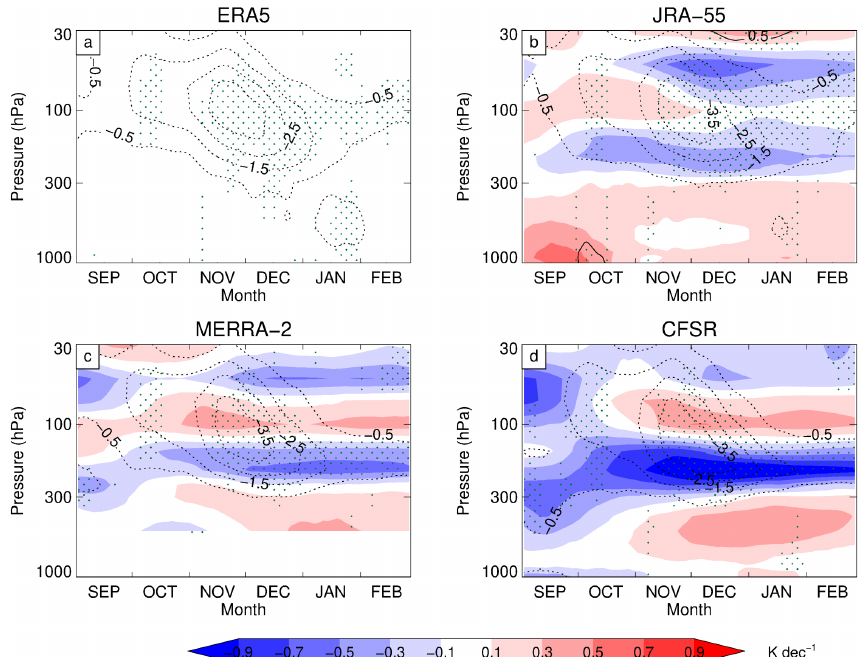
Figure A1. Time–height cross section of the trend in the zonally averaged temperature (contour intervals: − 0.5, − 1.5, − 2.5, and − 3.5K per decade) averaged over 70 to 87.5 ◦ S from 1980 to 2001 for ERA5 (a) , JRA-55 (b) , MERRA-2 (c) , and CFSR (d) . The shading represents differences from ERA5 at intervals of ± 0.1, ± 0.3, ± 0.5, ± 0.7, and ± 0.9K per decade. Results in the range 1000 to 500hPa are not included in panel (c) . Stippling denotes regions where the trends are significant at the 5% significance level. Note that for each panel the time series is